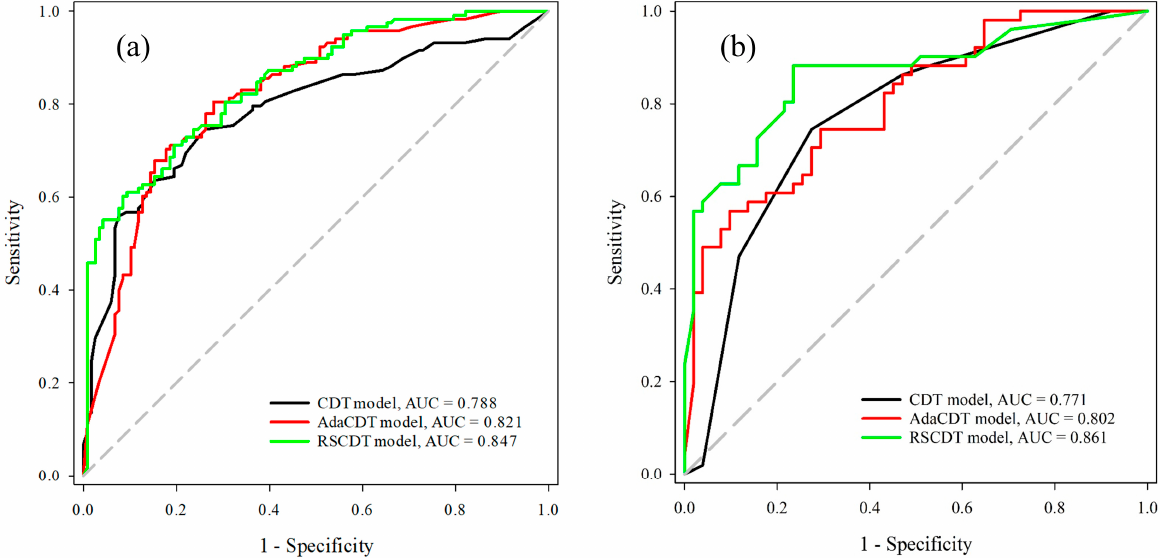
Figure 10. ROC curves and AUC analysis for LSM using the three models: ( a ) goodness-of-fit from the training data; ( b ) prediction rates from the validating data.